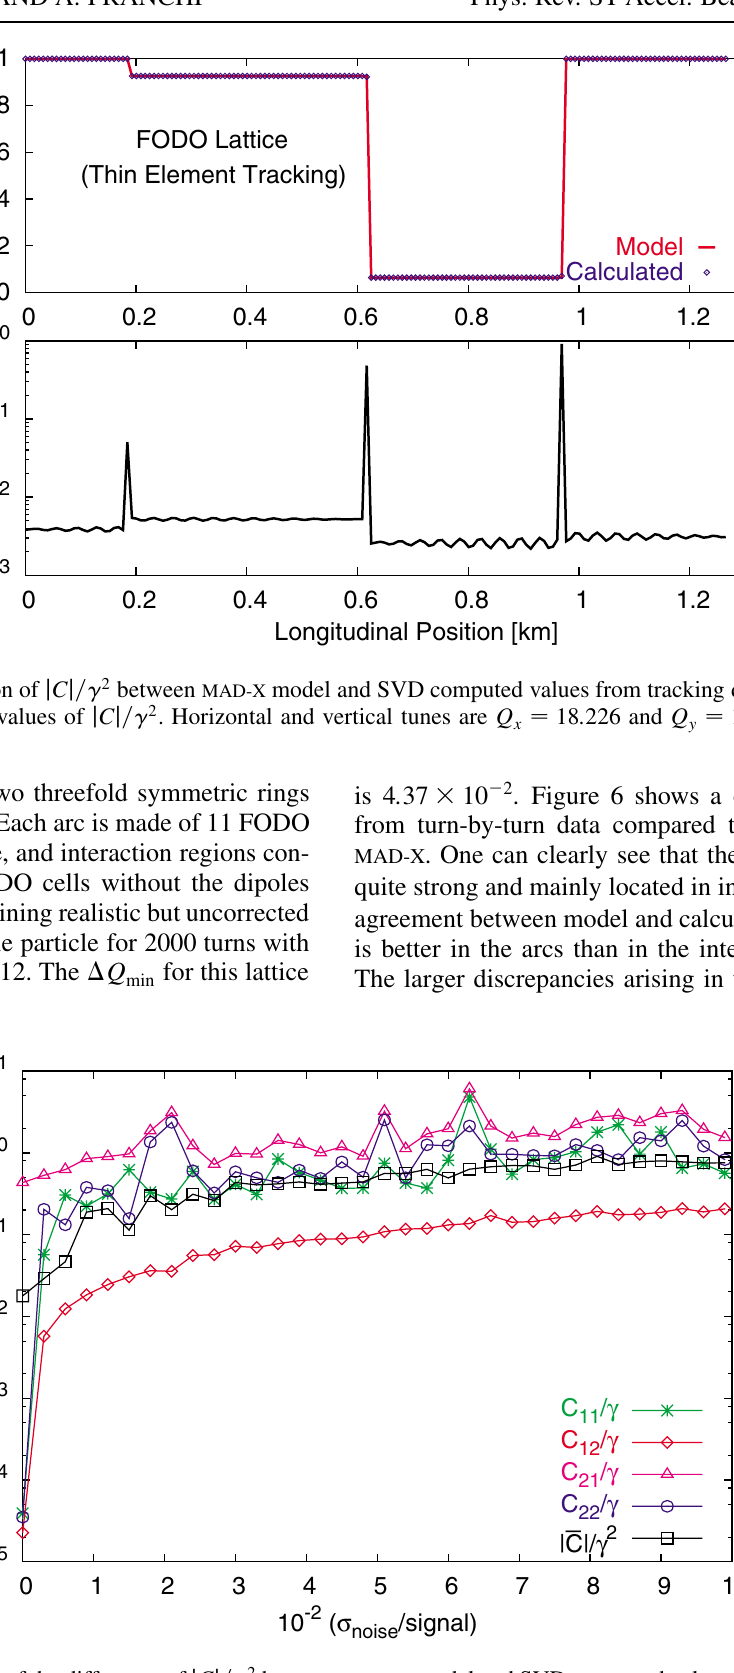
(cid:3) 18 : 226 and Q (cid:3) 17 : 257 , respectively. x y